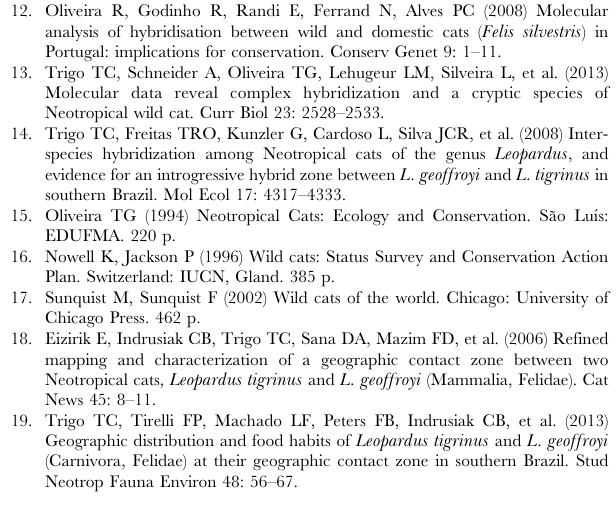
Figure S1 Species specific-haplotypes described by ref. [13] depicted as haplotype networks. (A) mtDNA ND5 gene, (B) X-linked introns of genes PLP1 and BTK , (C) Y-linked introns of genes ZFY and SMCY3 . Each unique haplotype is represented by a circle whose size is proportional to its frequency. Colors indicate the frequency of the haplotype in each population group: dark grey for Leopardus guttulus , light grey for Leopardus geoffroyi , and white for L. colocolo . Each haplotype nomination was the same used in [13], and the absence here of some haplotypes described in that study is due to the exclusion of the samples assigned to L. tigrinus from Northeastern Brazil. Table S1 Samples analyzed in the present study. The parental populations of both species include only the individuals used in the genotypes simulation. Table S2 Haplotypes used in this study from reference [13] and their respective GenBank accession